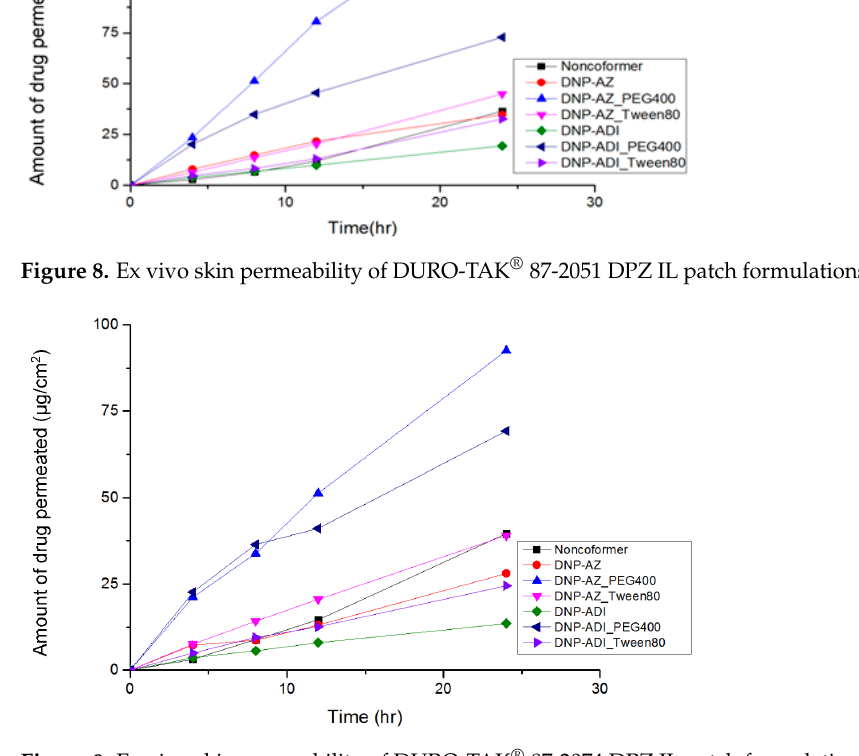
Figure 9. Ex vivo skin permeability of DURO-TAK ® 87-2074 DPZ IL patch formulation. (mean, n = 3).